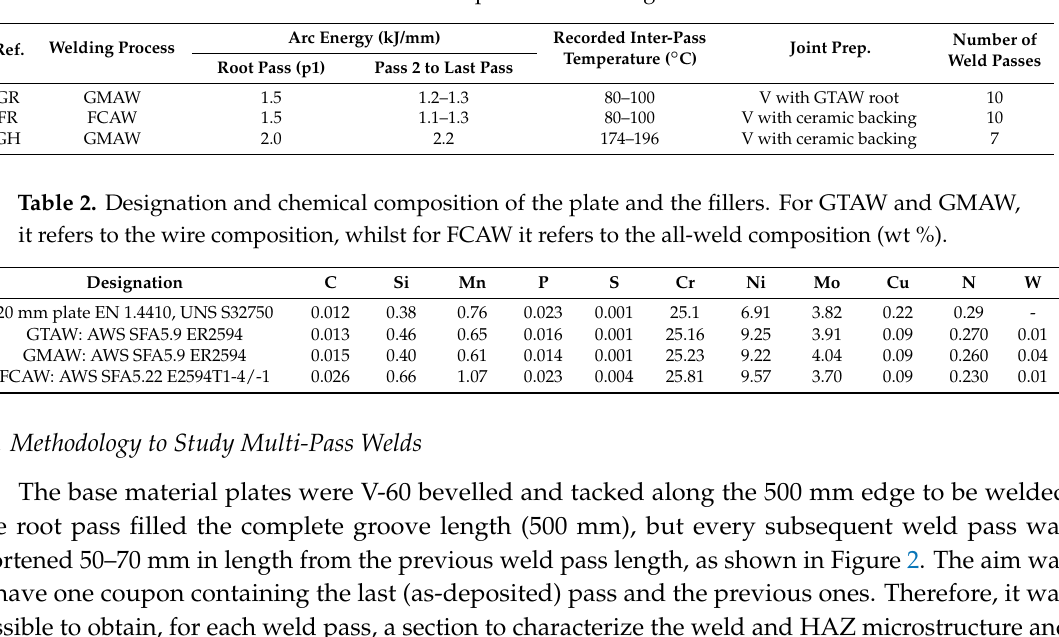
Figure 1. Welding sequence layout. ( Left ) FR weld; ( Center ) GR weld; ( Right ) GH weld. Table 1. Experimental settings.